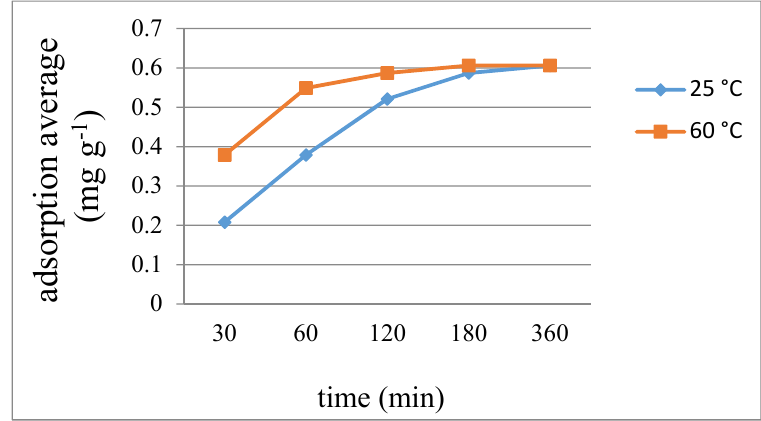
Figure 9. Average weight changes of complex 7 upon iodine adsorption.